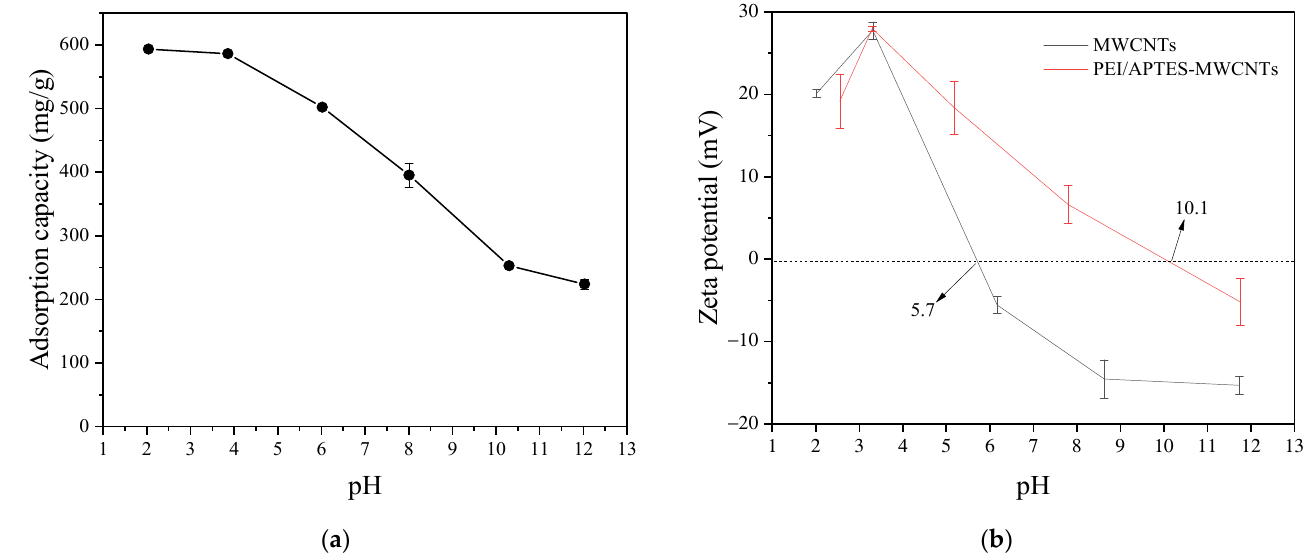
Figure 5. ( a ) Effect of pH on RY2 adsorption on PEI/APTES-MWCNTs and ( b ) zeta potential of MWCNTs and PEI/APTES-MWCNTs at different pHs.